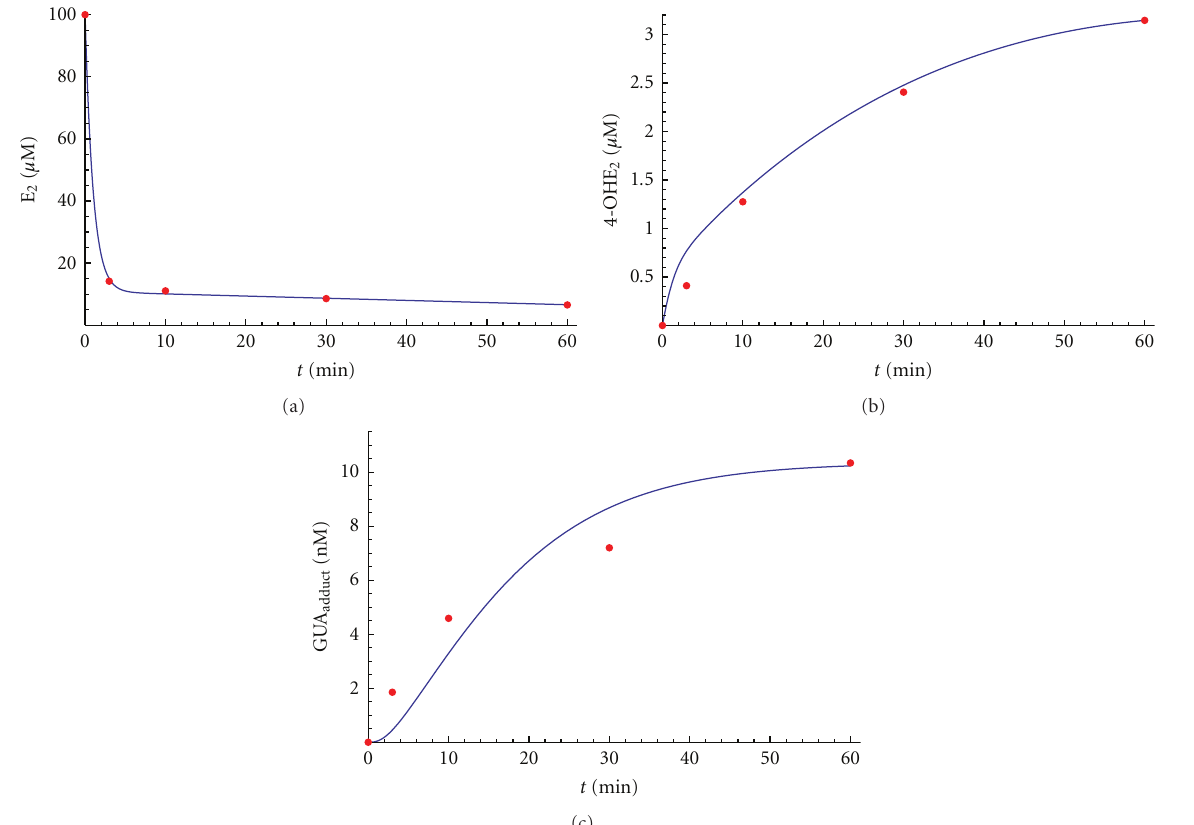
Figure 2: Comparison of stage 1 mathematical model (DNA damage) with experimental data. The metabolism of E 2 (a), 4-OHE 2 (b), and GUA adduct (c) is shown as a function of time. In each graph the dots represent the experimental data [2], and the curves are derived from the mathematical